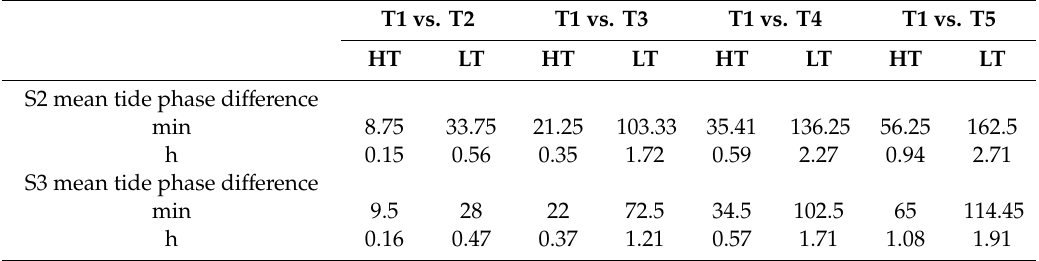
Table 9. Mean modelled tide phase differences. HT: high tide; LT: low tide. T1 vs.